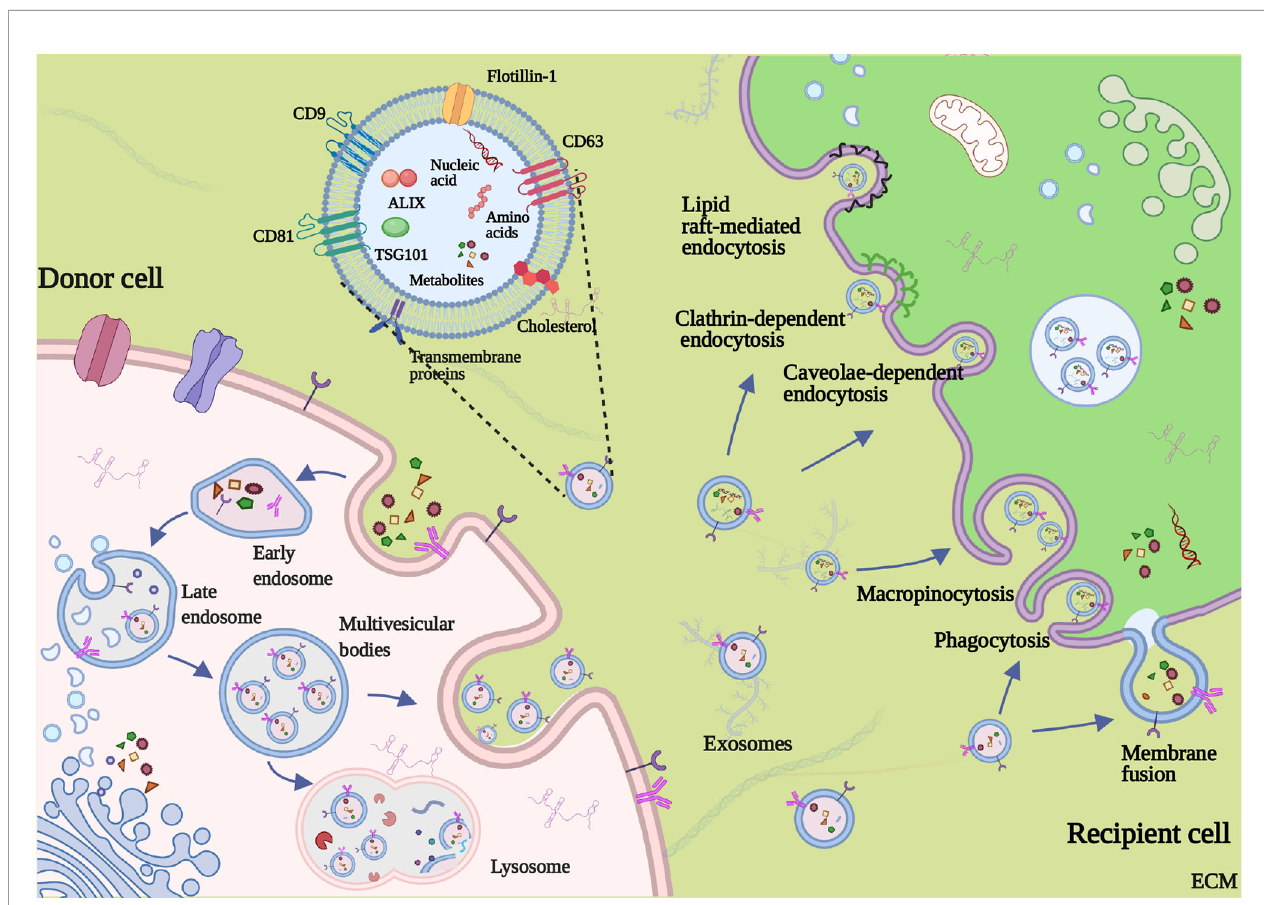
FIGURE 2 | Formation, secretion, and uptake of exosome. Invagination of the plasma membrane forms the early endosome. Then, inward invagination of endosomes gives birth to the formation of multivesicular bodies (MVBs) containing intraluminal vesicles (ILVs). Exosomes are eventually released by fusing of MVBs to the plasma membrane and the exocytosis of ILVs. The mechanism of exosome uptake includes direct fusing with the plasma membrane, macropinocytosis, phagocytosis, caveolin-mediated, lipid raft-mediated endocytosis, and clathrin-dependent